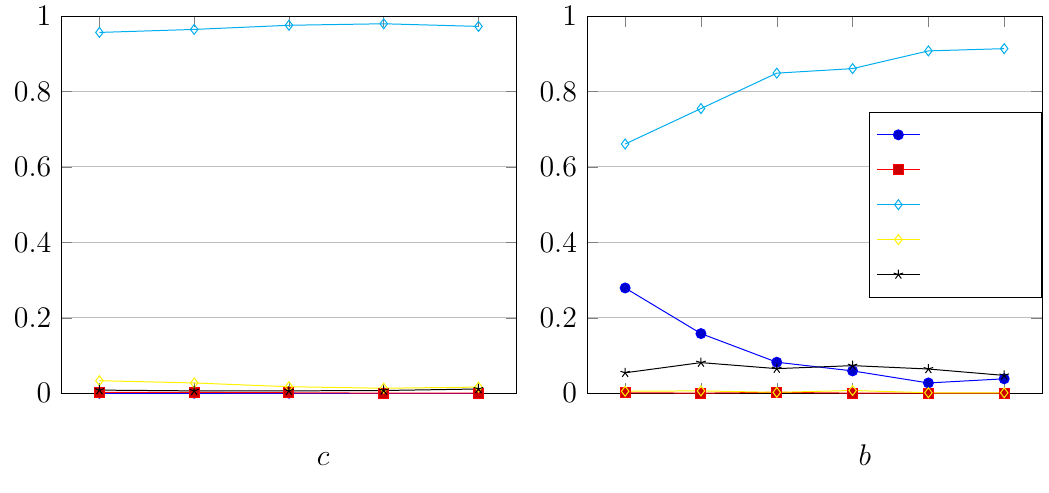
Figure 2: Proportion of simulation runs are predominated by a particular strategy or going extinct as a function of c versus b . For all simulations ρ =100. Left panel shows proportion of simulations for varying costs (with b =0.7); right panel shows proportion of simulations for varying benefits with high cost ( c